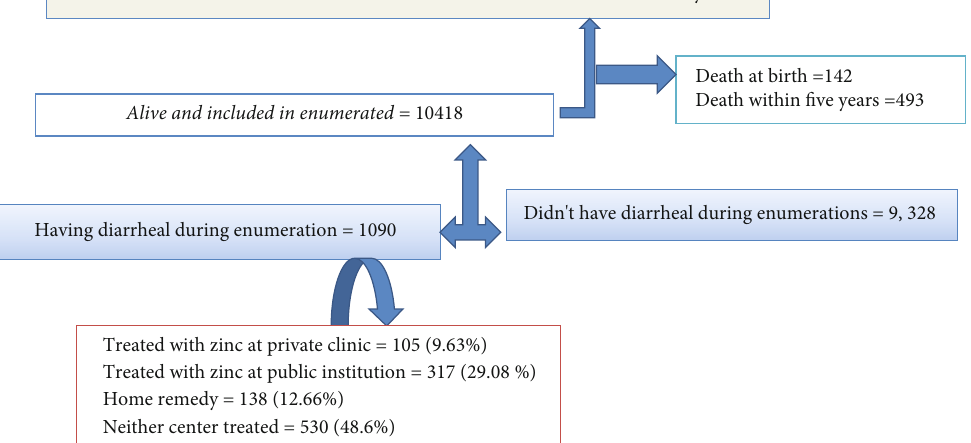
Figure 1: Sampling procedure of therapeutic zinc utilization for diminutions of acute diarrhea morbidity among under- fi ve children in